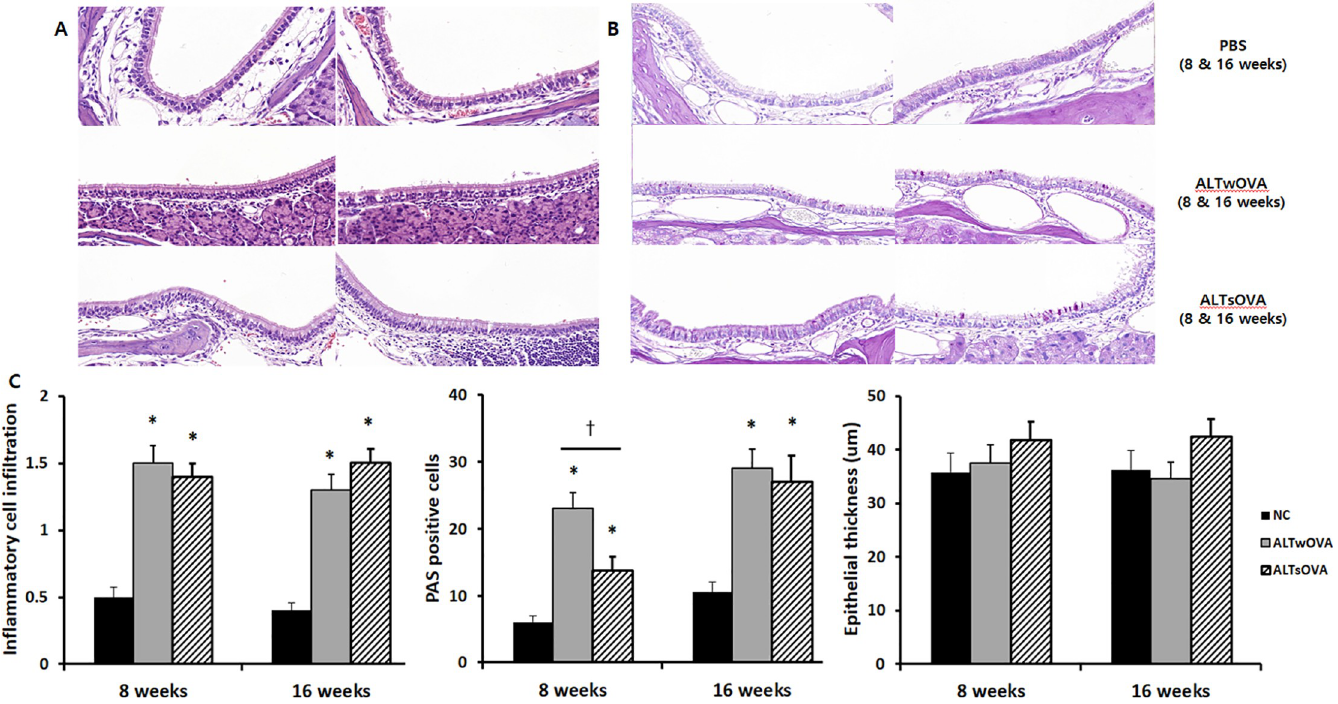
Fig 6. Histologic characteristics of the Alternaira induced Chronic RhinoSinusitis (CRS) mouse model. Inflammatory cell infiltration (A, x400) and periodic acid- Schiff (PAS) positive cells (B, x400) were significantly increased in sinonasal mucosa of allergic and non-allergic CRS mouse model of the Alternaira induced chronic rhinosinusitis mouse model (3–4 mice per group). NC: negative control, ALTwOVA: Alternaria instillation with ovalbumin (OVA) presensitization, ALTsOVA; Alternaria instillation without ovalbumin (OVA) presensitization. � p < 0.05 vs NC group, †p < 0.05 vs with or without OVA group.